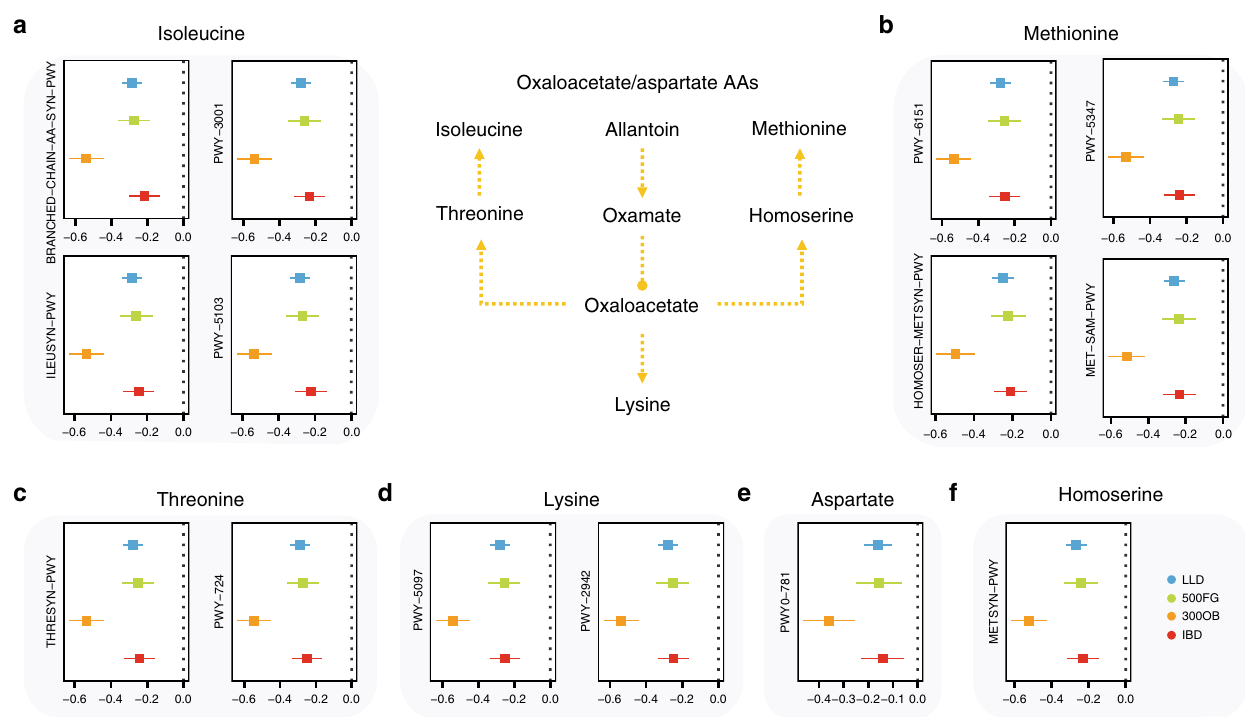
Fig. 6 Allantoin degradation pathway links to glycaemia in obesity. The allantoin degradation pathway shows stronger negative correlation with 14 amino acid biosynthesis pathways in the obesity cohort compared to the other cohorts. These pathways represent the biosynthesis of six amino acids: a isoleucine (PWY-5103, PWY-3001, BRANCHED-CHAIN-AA-SYN-PWY and ILEUSYN-PWY), b methionine (PWY-6151, PWY-5347, MET-SAM-PWY and HOMOSER-METSYN-PWY), c threonine (THRESYN-PWY and PWY-724), d lysine (PWY-5097 and PWY-2942), e aspartate (PWY0-781) and f homoserine (METSYN-PWY). All six amino acids are involved in the oxaloacetate/aspartate amino acids biosynthesis pathway. Lines with arrows represent metabolic relationships. Lines with a circle represent an inhibitory role in a metabolic pathway. N = 2379 independent samples are involved ( N LLD = 1135, N 500FG = 450, N 300OB = 298, N IBD = 496). The forest plots show co-abundance strength and direction in each cohort, with square dot for the correlation coef fi cient and bar for the 95% con fi dence